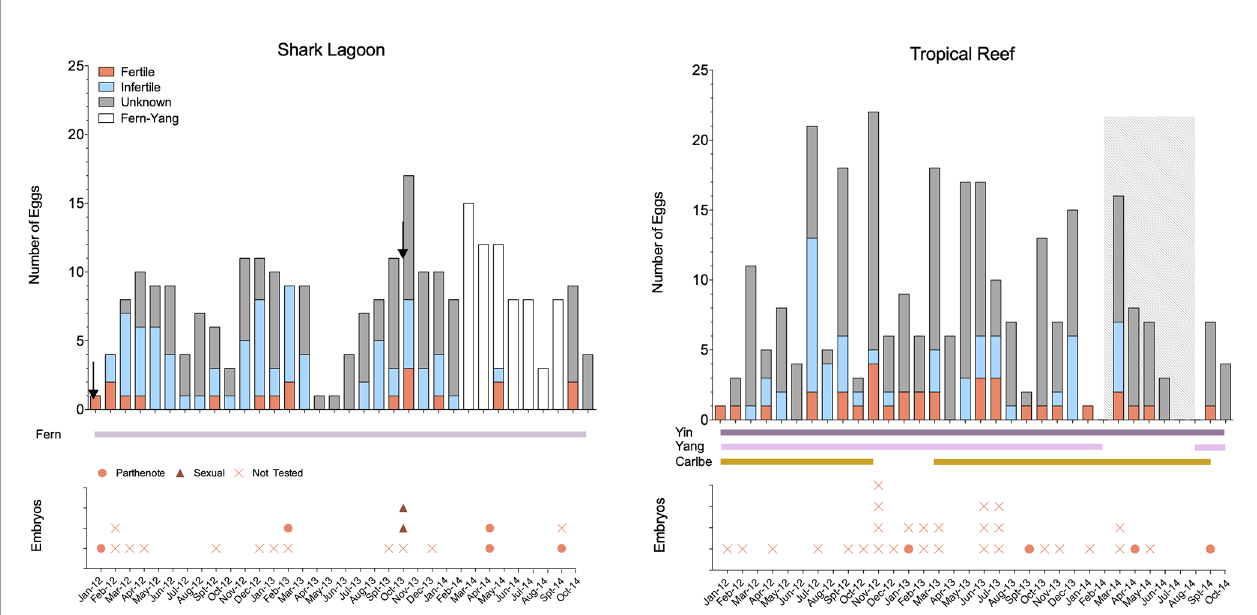
FIGURE 2 | Yolked egg laying activity by month-year for Fern in Shark Lagoon (Left) and Yin and Yang in Tropical Reef (Right). Egg assignment into Infertile, Fertile and Unknown categories is based on the hierarchy shown in Figure 1 . Shark residency for each exhibit is shown in solid, horizontal bars at the bottom of each plot. From February 2014 until August 2014 (gray rectangle) select eggs (Fern and Yang, open bars shown on left plot) from both exhibits were incubated together, precluding con fi rmation of dam, and were not included in analyses. Arti fi cial inseminations performed in Fern (left) are show with arrows. Corresponding plots of hatched and unhatched embryos with genetic assignment are shown for each exhibit by